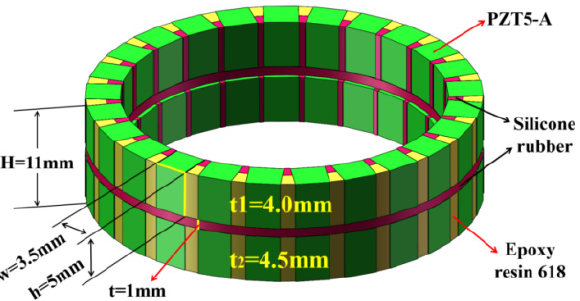
Figure 3. Structure of the double-ring stacked piezoelectric composite.